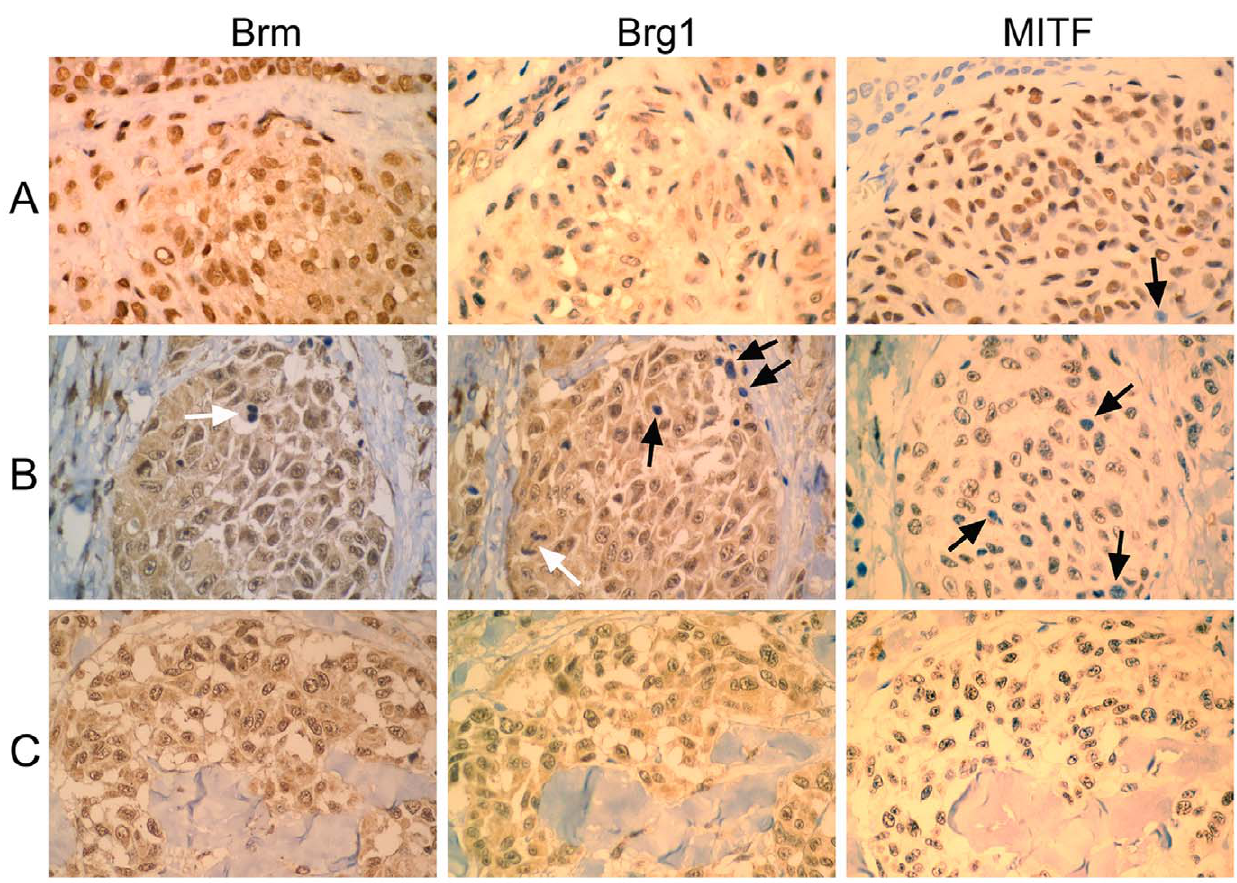
Figure 5. Immunostaining of BRM, BRG1, and MITF in nevi and primary melanomas. A. Intradermal nevus; B and C. Primary melanomas. Parallel sections (5 m m) were stained with antibodies against BRM (left), BRG1 (middle), and MITF (right). Protein expression was analyzed in intradermal or compound nevi (5 sections) and primary melanomas . 1 mm in thickness (9 sections) and representative images were shown. Black arrows indicate negative interphase nuclei in BRG1 and MITF staining, open arrows mark BRM- or BRG1-negative mitotic nuclei. Scoring (0–3) is described in Materials and Methods. Magnification, 6 400.